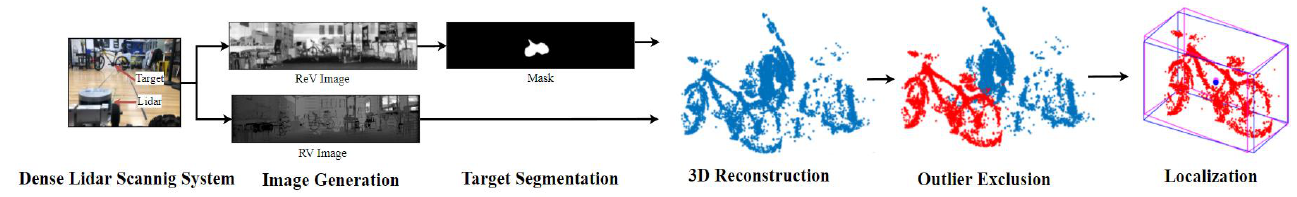
Figure 1. The pipeline of the paper.